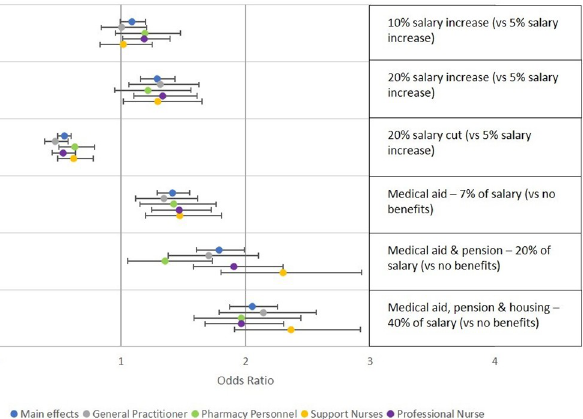
Fig 3. Preferences regarding salary and benefits packages. This figure shows results of models stratified by cadre, including odds ratios and 95% confidence intervals, for attributes related to salary and benefits.